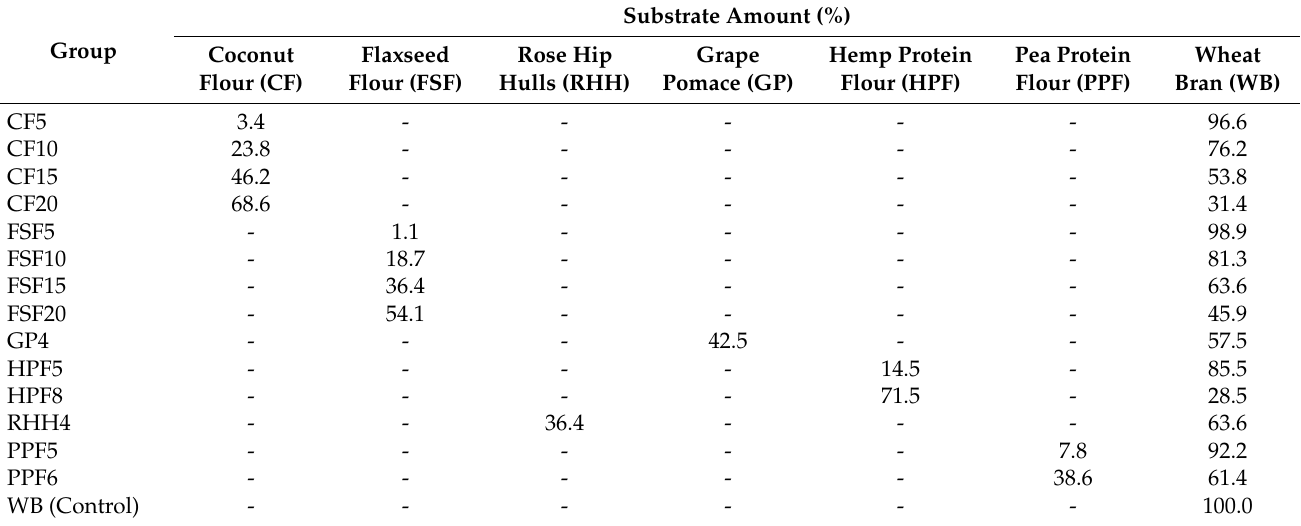
Table 1. Compositional amount (%) of experimental diets for Tenebrio molitor larvae.